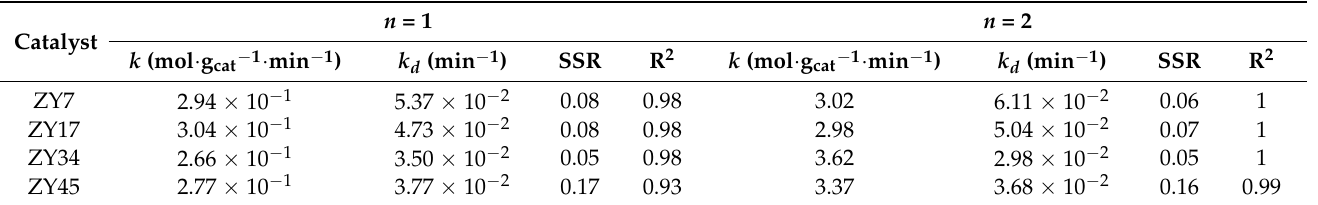
Table 2. Reaction and deactivation rate constants and discrimination parameters for the reaction between acrolein and ammonia over the Y-type